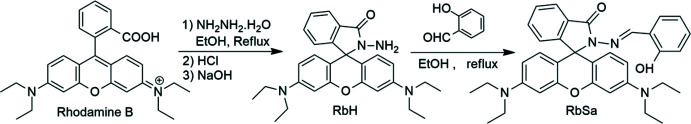
The synthetic route and the structures of RbSa.